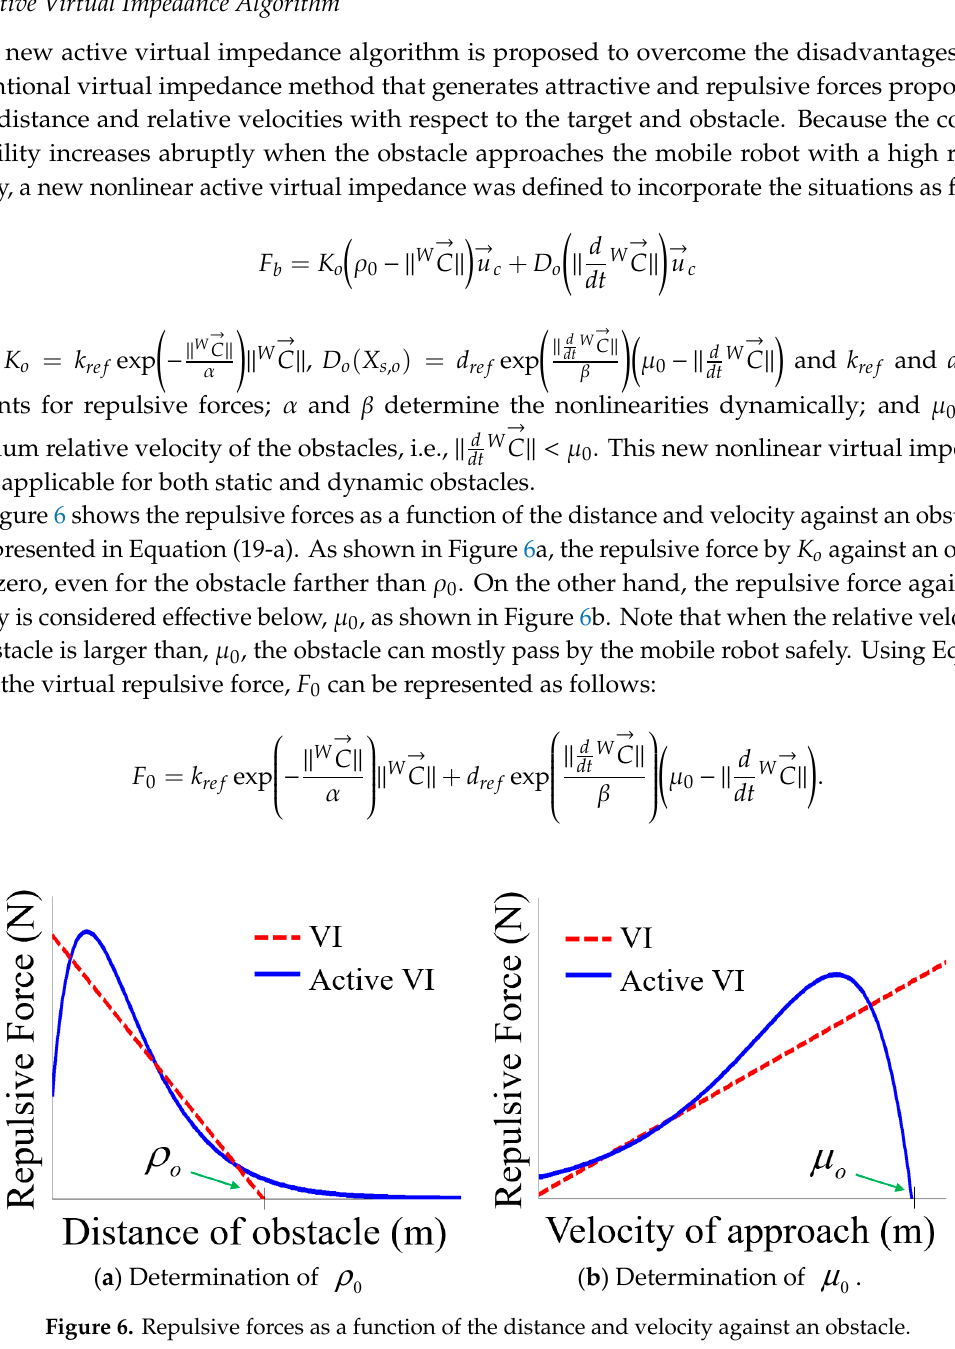
Figure 6. Repulsive forces as a function of the distance and velocity against an obstacle.